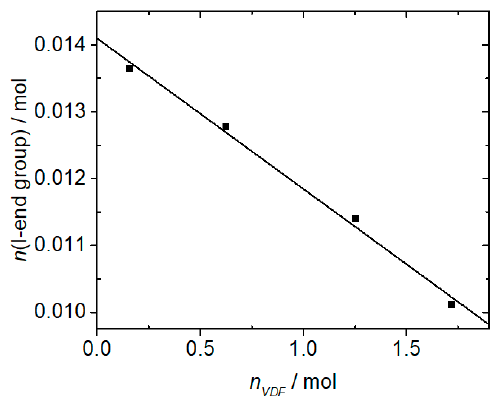
Figure 3. Evolution of I end group functionality with amount of VDF consumed in the semi-batch polymerization at 75 °C and 20 bar with 7.5 mmol C 4 F 8 I 2 (sample 2).